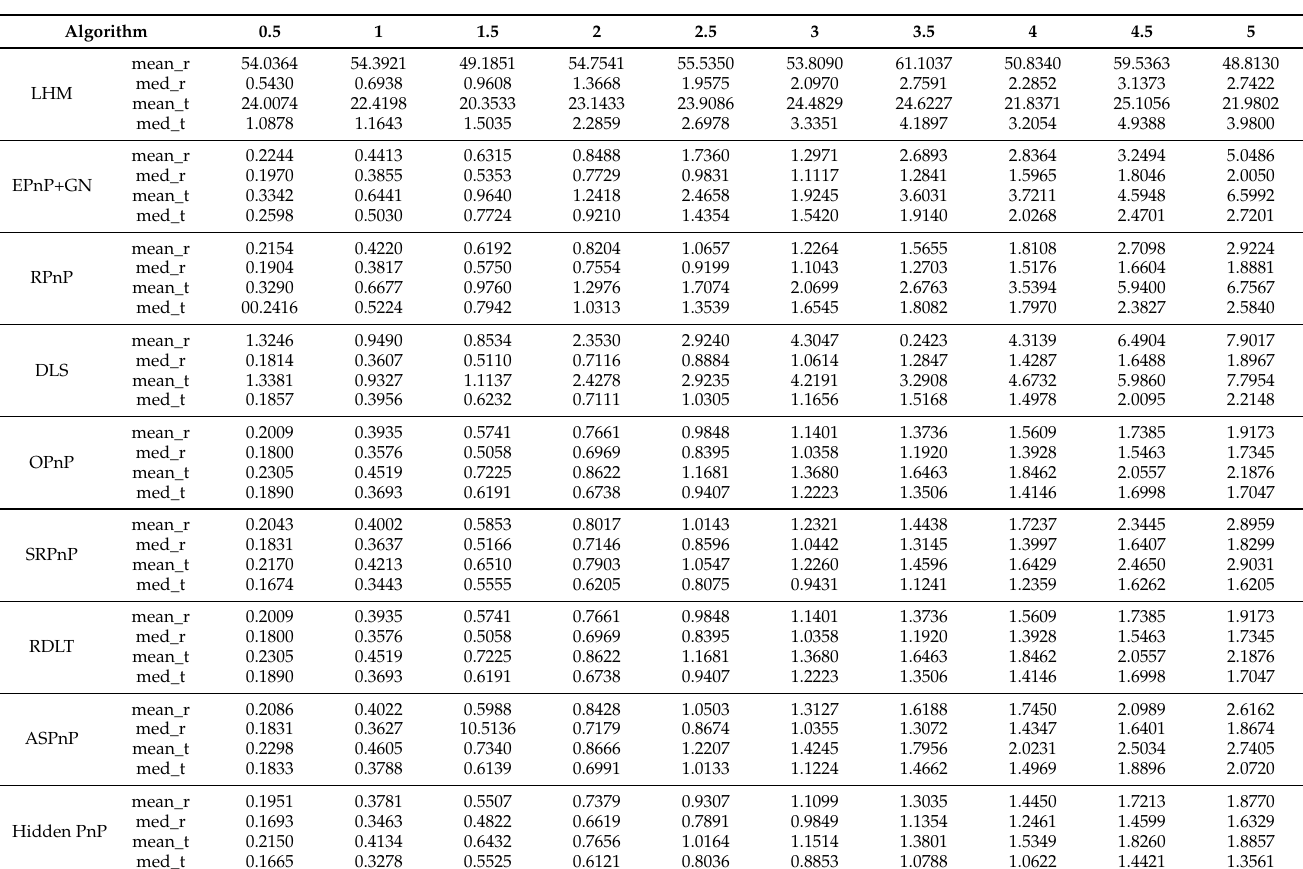
Table A6. Error comparison in Quasi-singularity